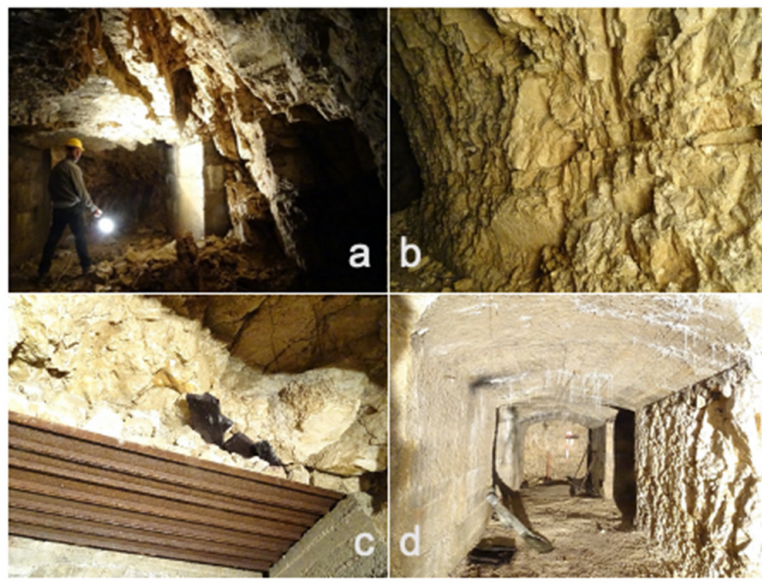
Figure 2. View of ( a ) vault collapse within the tunnel; ( b ) limestone outcrop; ( c ) vault protected by metal liner; ( d ) limestone outcrop + concrete